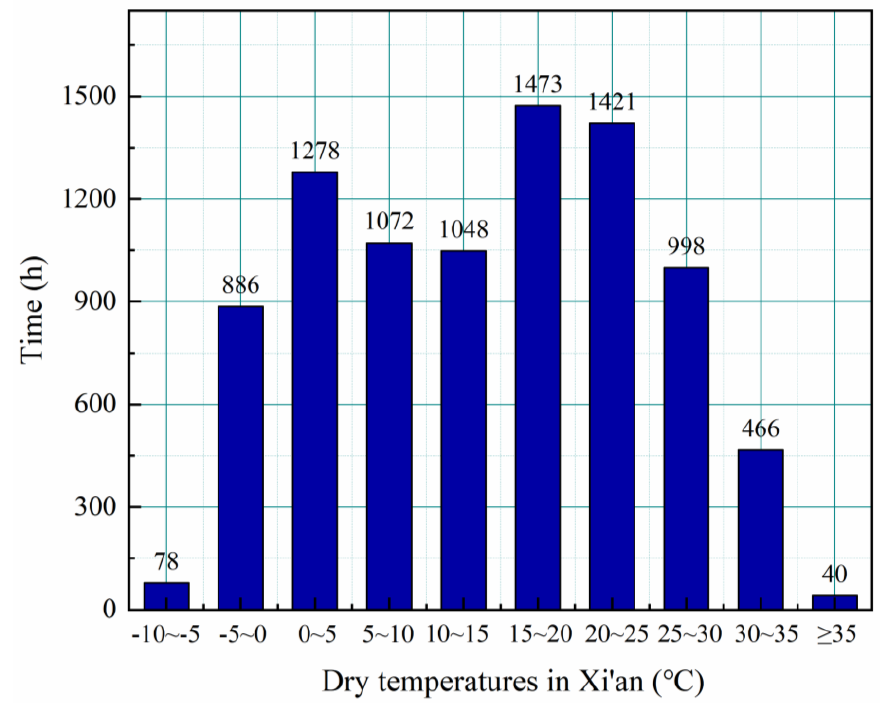
Figure 5. Number of hours per year with these dry-bulb temperatures in Xi’an.